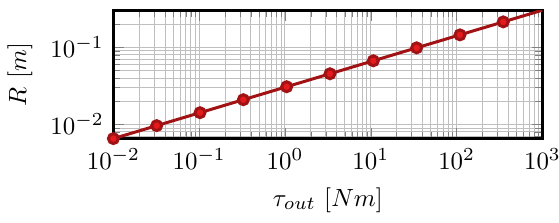
Figure 21. Scaling of the friction wheel radius with output